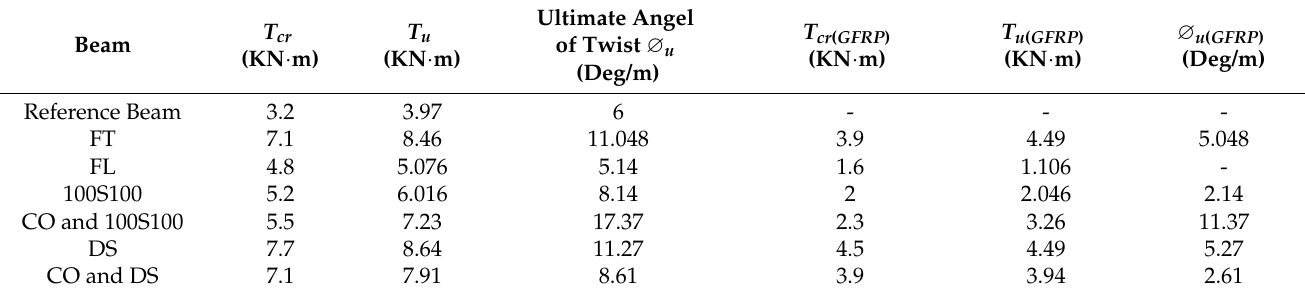
Table 5. Cracking torque, ultimate torque, ultimate angle of twist, and effects of fibers on the cracking torque, ultimate torque, ultimate angle of twist for FT, FL, 100s100, CO and 100s100, DS, and CO and DS (Numerical